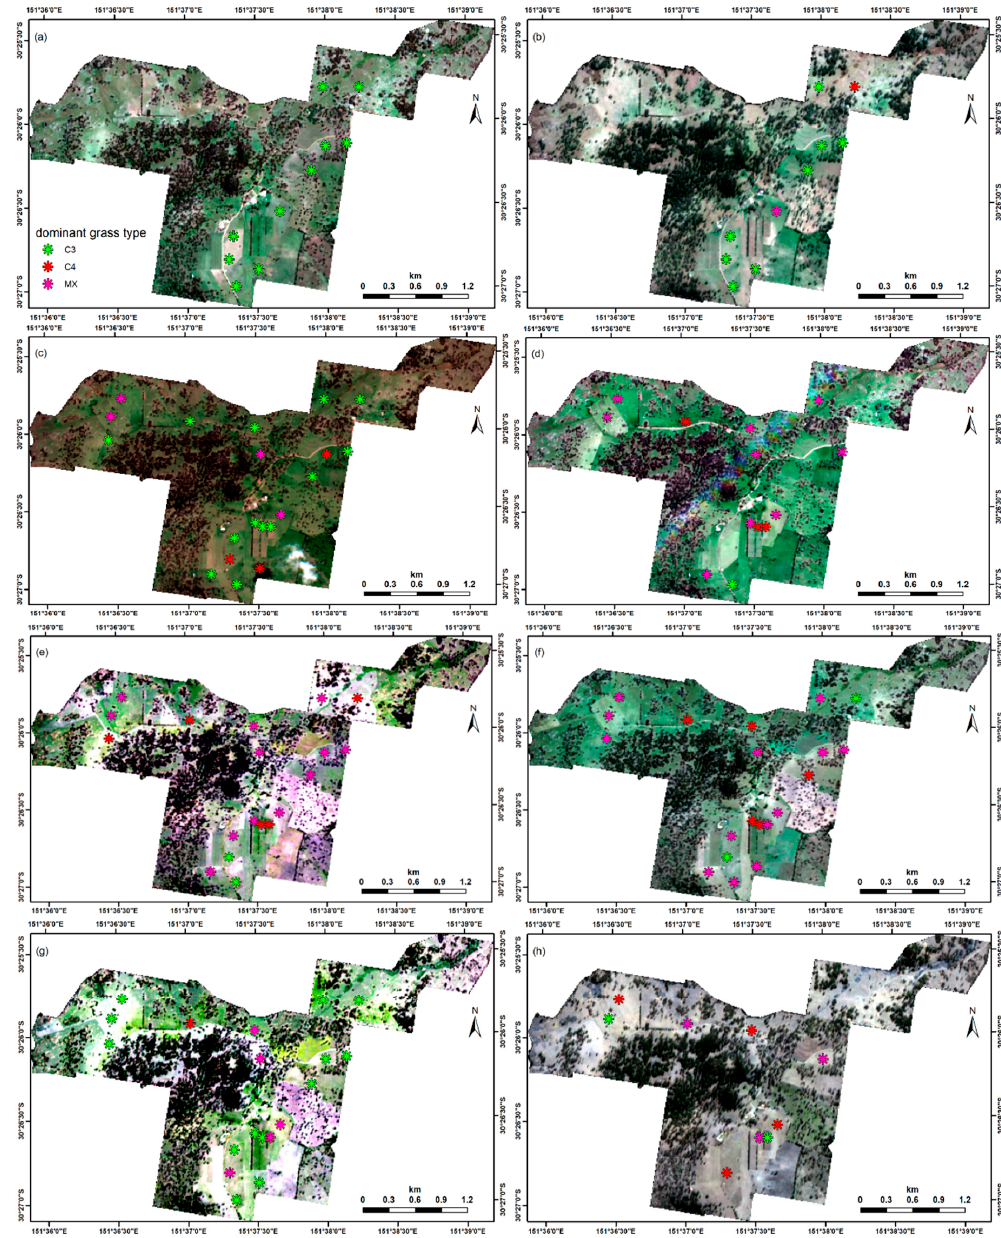
. Figure 2. Spatio-temporal characterization of C3, C4, and mixed C3/C4 grasses. The images used